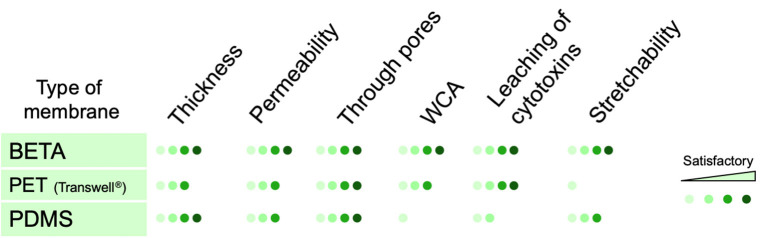
Qualitative comparison between key properties of conventional porous membranes (PET and PDMS) used for static and dynamic (cell-stretch) in vitro lung models at the air-liquid interface and the BETA membrane presented here. The scores are based on biomimetic relevance as compared to the alveolar basement membrane. The permeability was measured as apparent permeability (Papp) for FITC-dextran (4 kDa). Stretchability and through pores refer to the elastic modulus and pores connecting the apical and basal sides of the membrane, respectively.